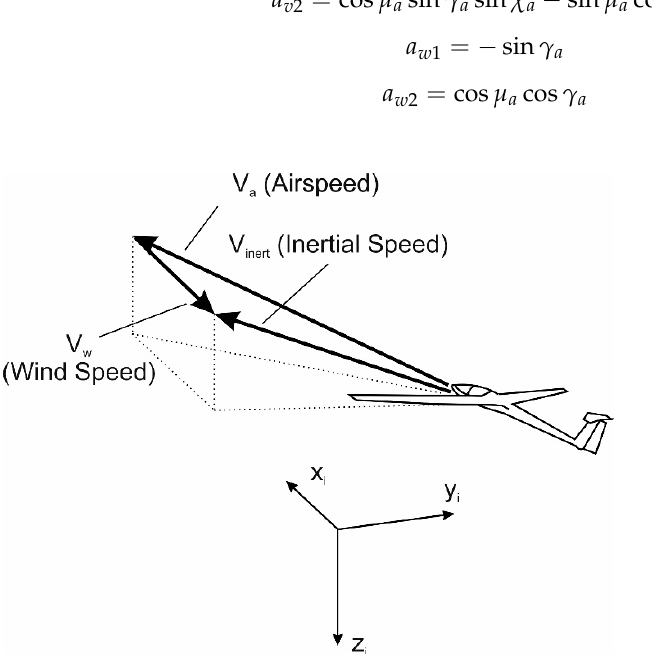
Figure 2. Speed vectors and inertial coordinate system. (The 𝑥 axis is chosen parallel to the wind speed vector 𝑉 (cid:3050) and pointing in the opposite direction.).